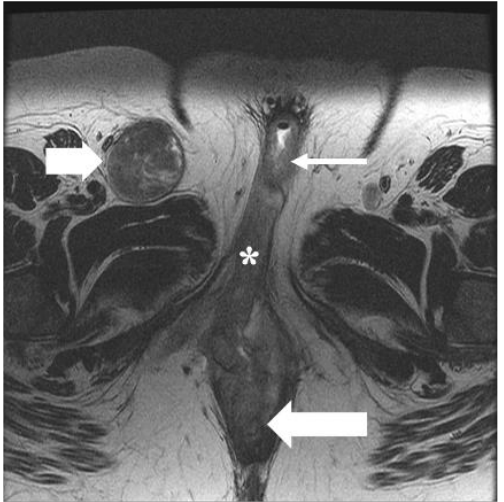
Figure 6. FIGO stage III. A 49-year-old female with squamous cell carcinoma of the vulva. Axial T2 weighted MRI image shows infiltrative vulvar tumor (asterisk) involving, anteriorly, the lower one-third of the urethra (long thin arrow) and, posteriorly, the lower one-third of the anus (long thick arrow). Moreover, there is a metastatic right inguinal lymph node (short thick arrow). The findings correspond to FIGO stage IIIB.